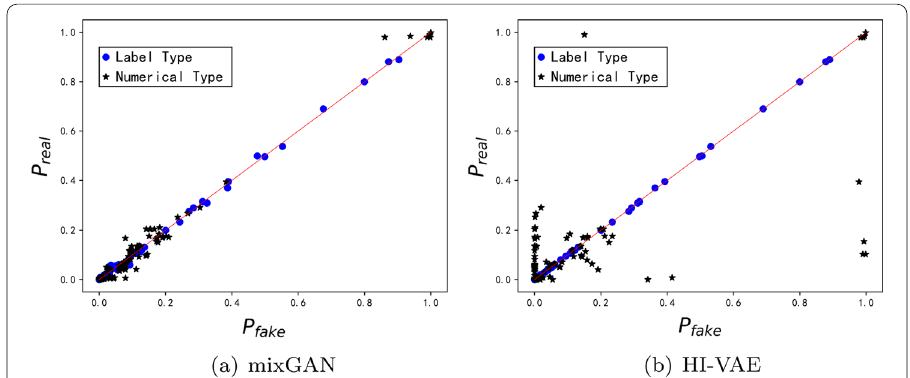
Fig. 3 Generated the distribution map for matching the independent attributes of data and real